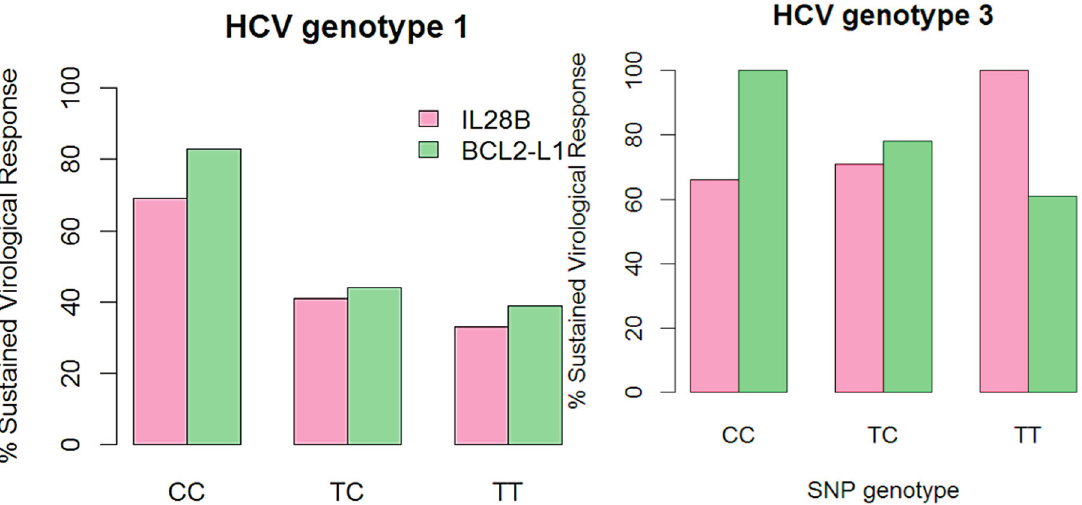
Figure 1. Rates of sustained virological responses according to interleukin-28B and BCL2L1 genotypes in individuals infected with hepatitis C virus genotypes 1 or